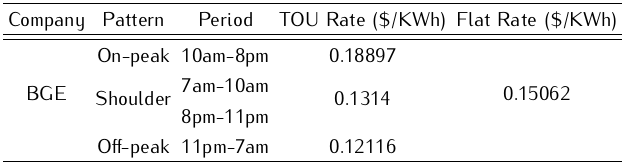
Table 3. TOU and flat rates from BGE utility (summer) – 2009 data